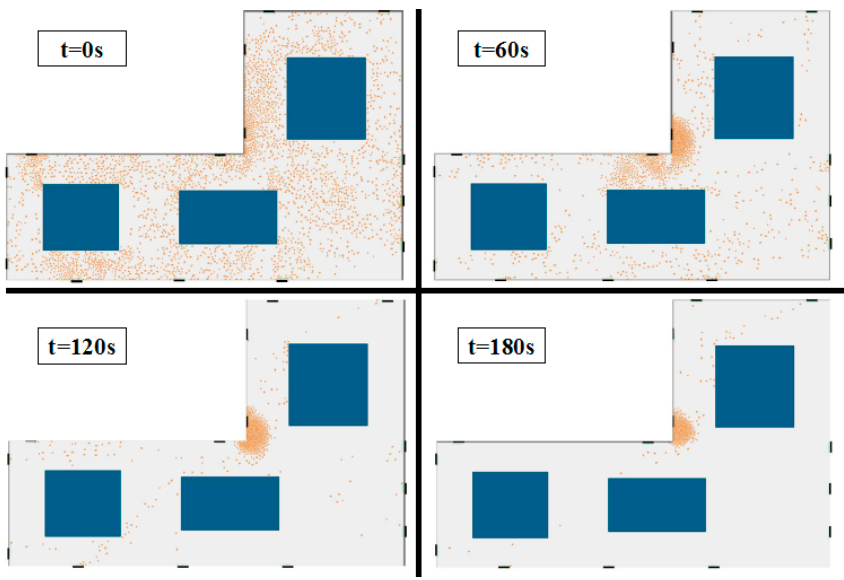
Figure 27. Screenshot of Massmotion software simulation.